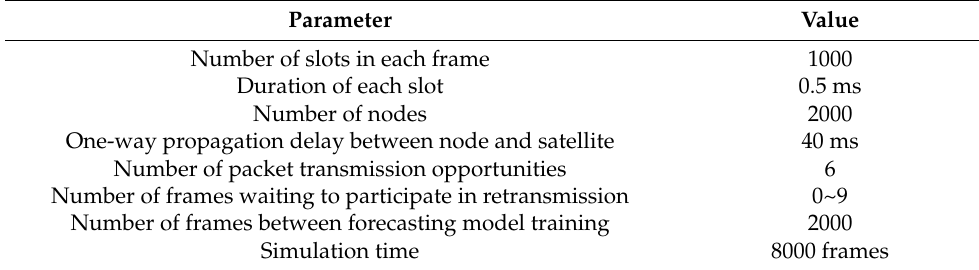
Table 1. Experimental parameter